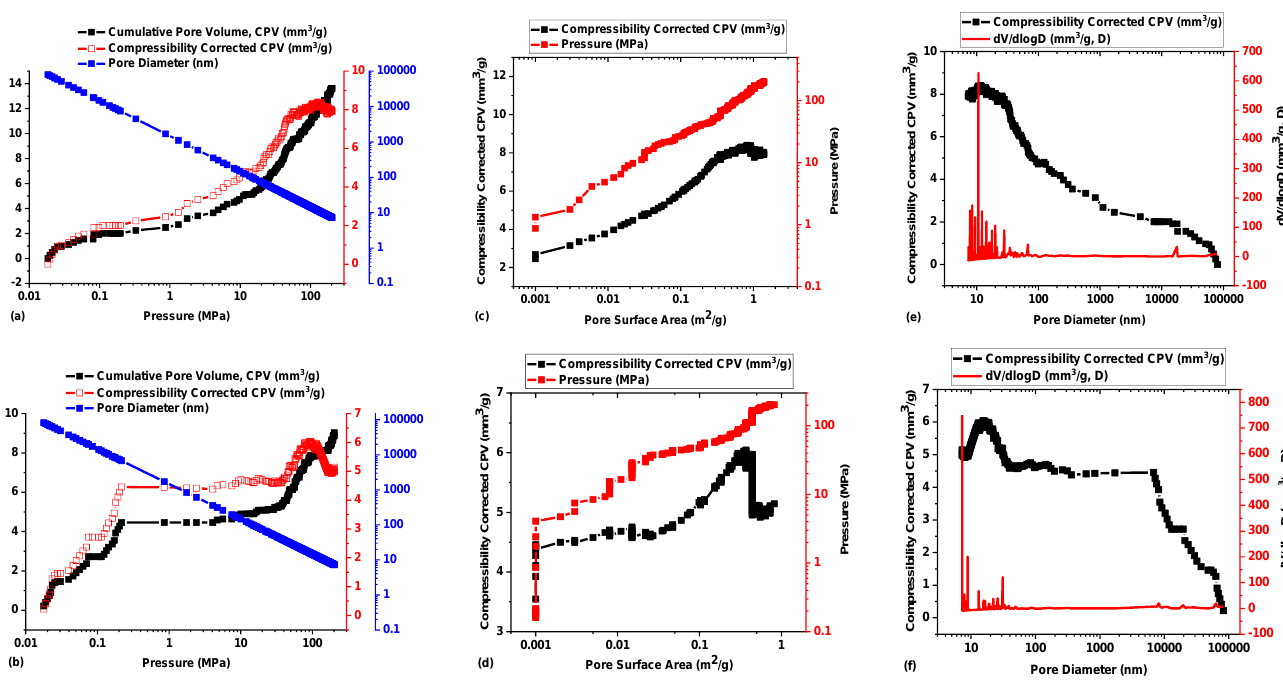
Figure 10. Pore system characterization of shale samples. ( a ) Eagle Ford and ( b ) Wolfcamp shales’ CPV and CCCPV versus mercury intrusion pressure, ( c ) Eagle Ford and ( d ) Wolfcamp shales’ CCCPV and mercury intrusion pressure versus PSA, and ( e ) Eagle Ford and ( f ) Wolfcamp shales’ CCCPV and dV/dlogD versus pore diameter.